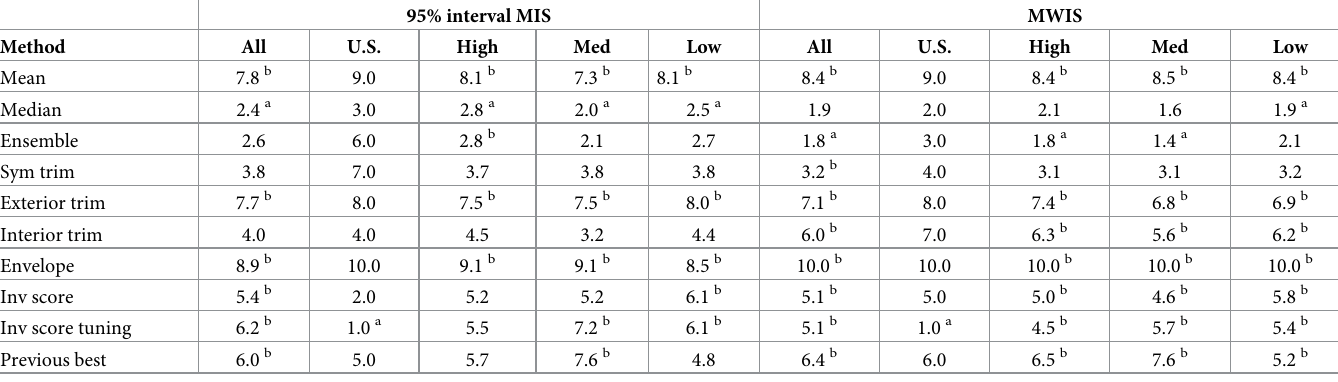
Lower values are better. a indicates best method in each column b significantly worse than the best method, at the 5% significance level.